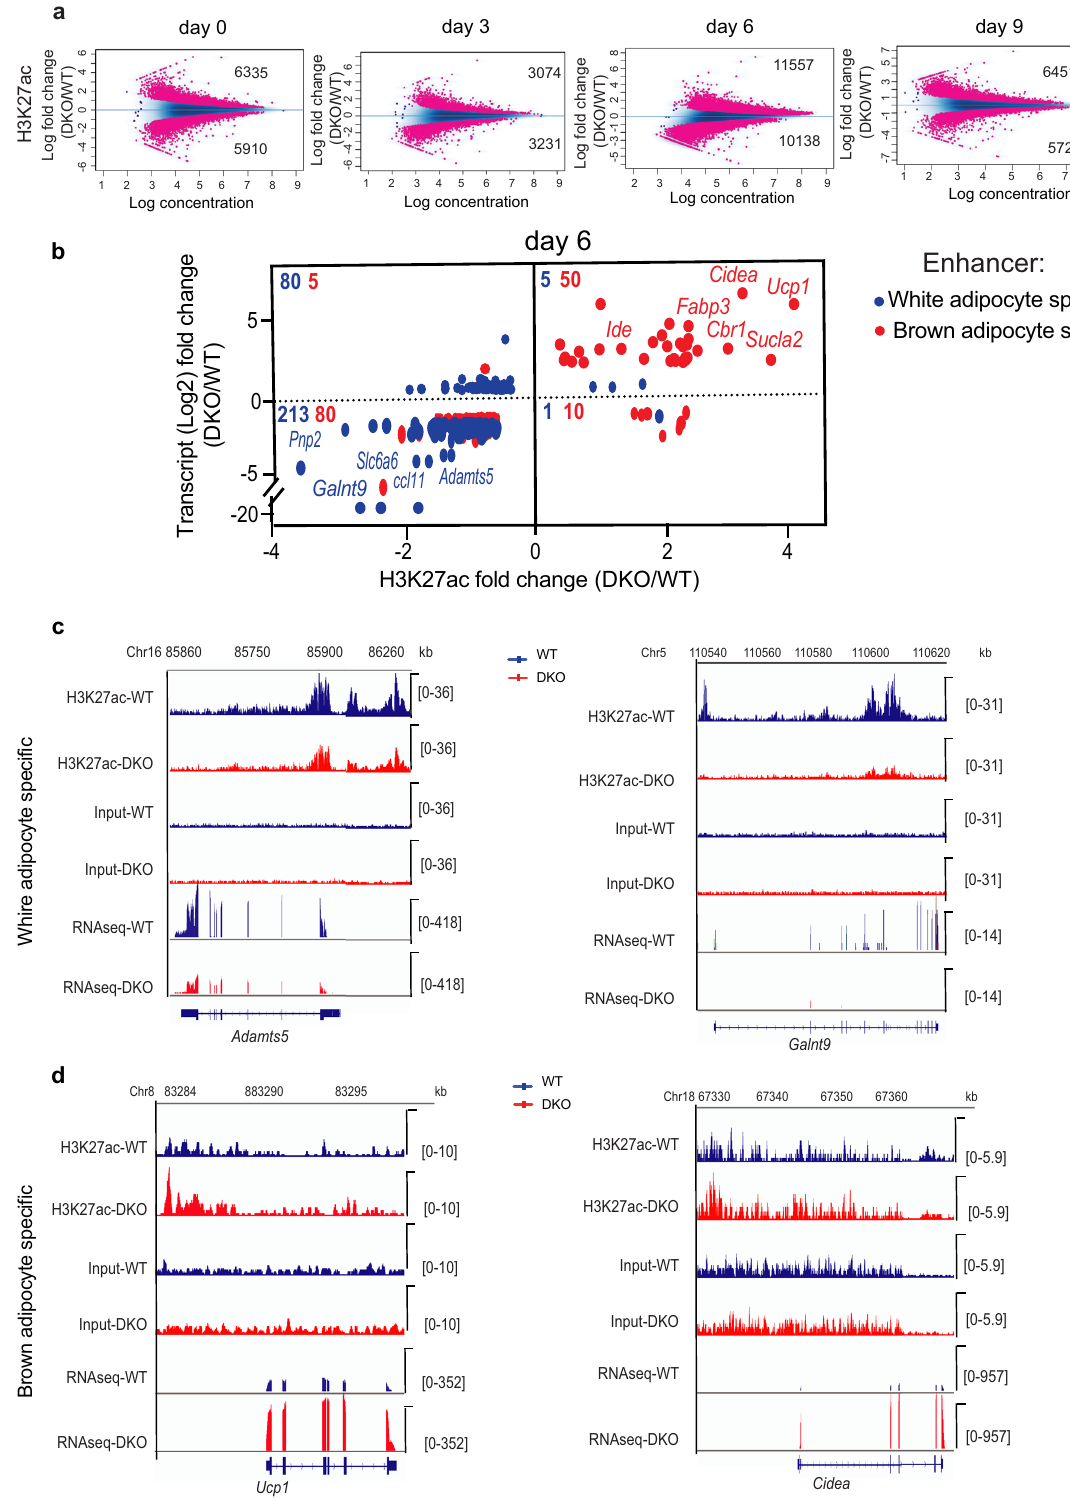
Fig. 6 | HMGNs affect H3K27ac levels and adipocyte type-speci fi c gene expression during the browning of white preadipocytes. a MA plot showing differences in H3K27 acetylation between WT and DKO preadipocytes induced browningat0-day,3rdday,6thday,and9thday.Alistofallthesigni fi cantlyaltered H3K27ac regions is shown in supplementary data 6. Data are from three biological